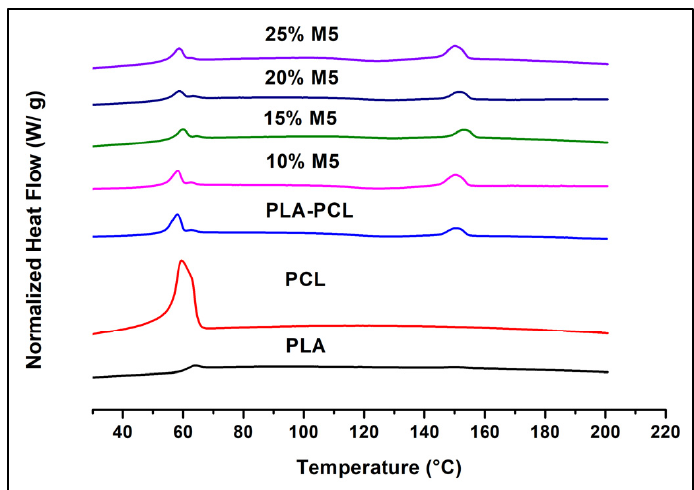
Figure 14. DSC curves of PLA, PCL, their blend, and their composites.